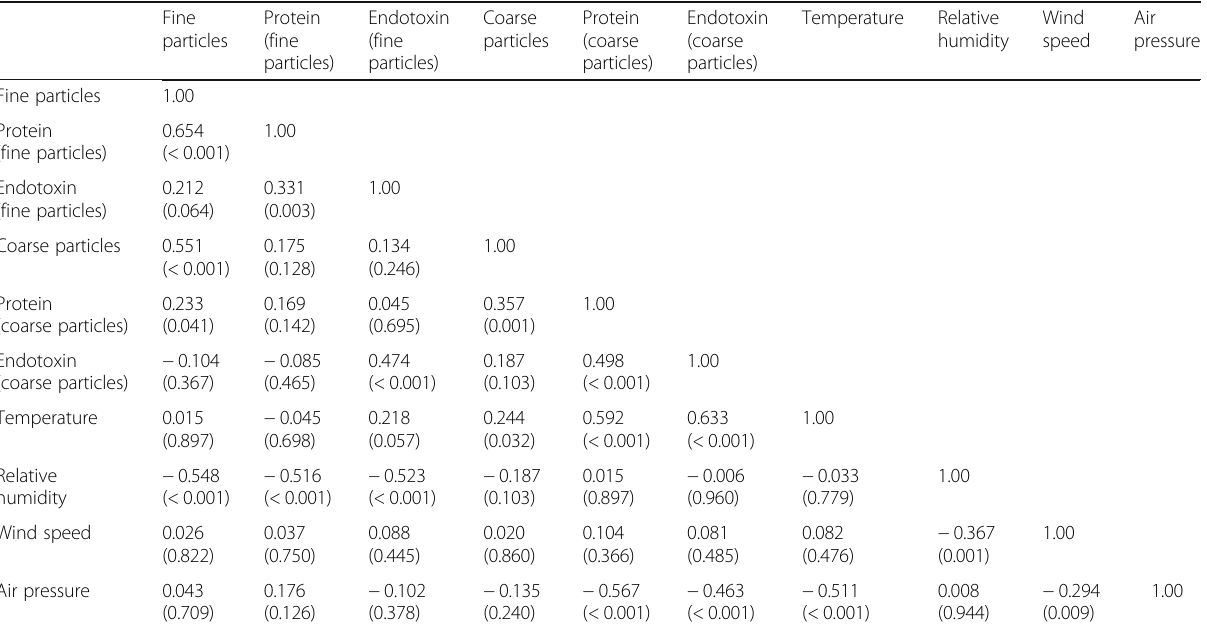
Table 3 Correlation coefficient ( p value) for environmental factors